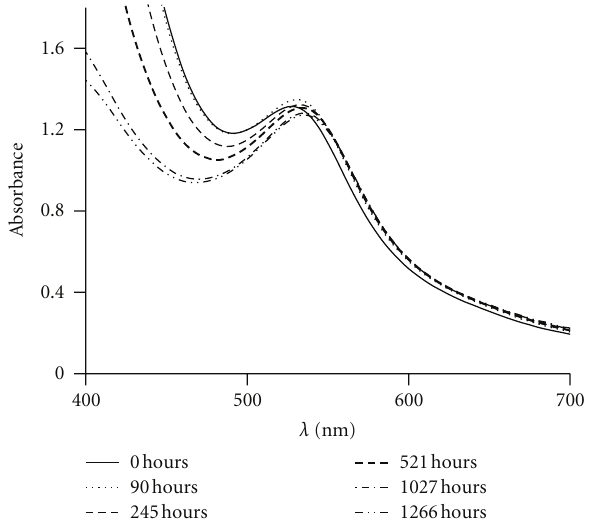
Figure 6: UV-Vis spectra of a typical cell over the exposure period shown.